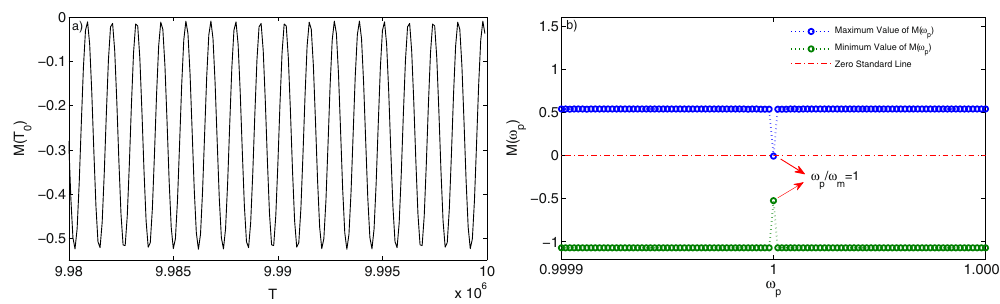
Figure 10. ( a ) is the M ( T 0 ) when the system is parametrically driven with ω p = 1. ( b ) is the plotting of M ( T 0 ) with a very narrow varying range around ω p =